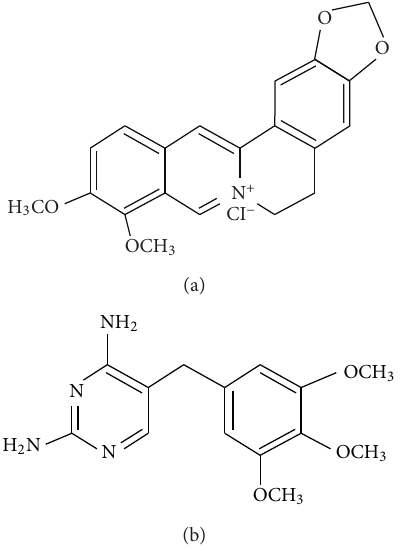
F 1: e chemical structures of (a) berberine hydrochloride and (b)